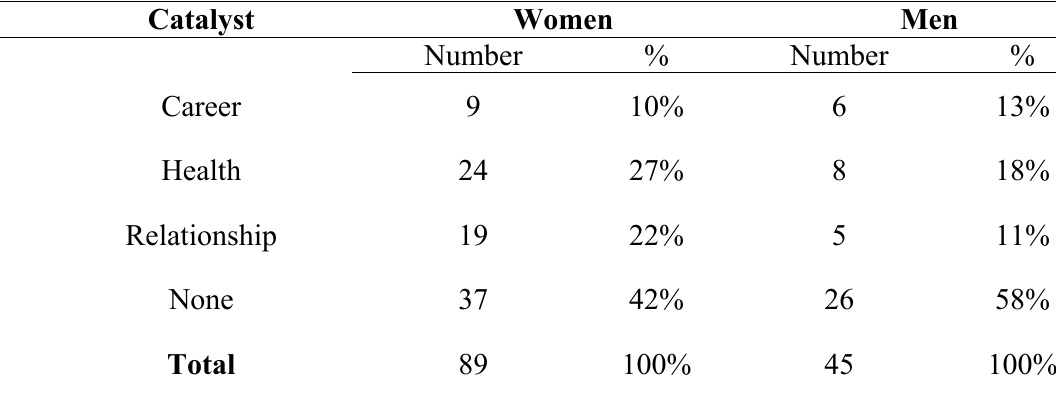
Table 1 : Gender and motivation to